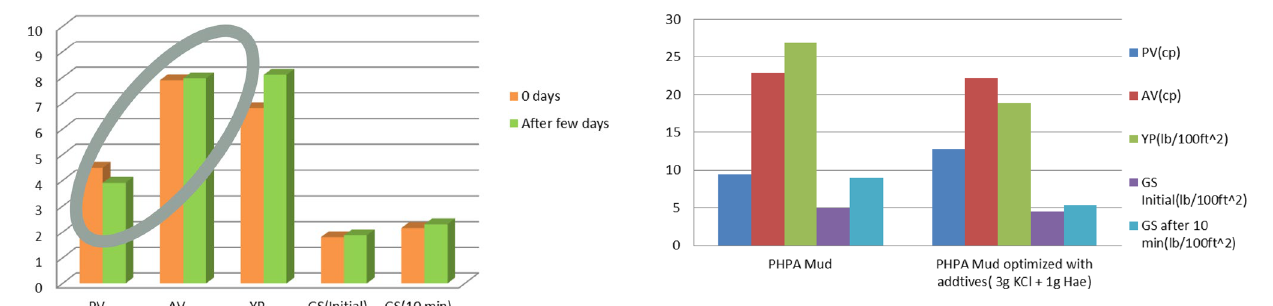
Fig. 27 Rheological properties of optimized CMC–bentonite mud in accordance with time